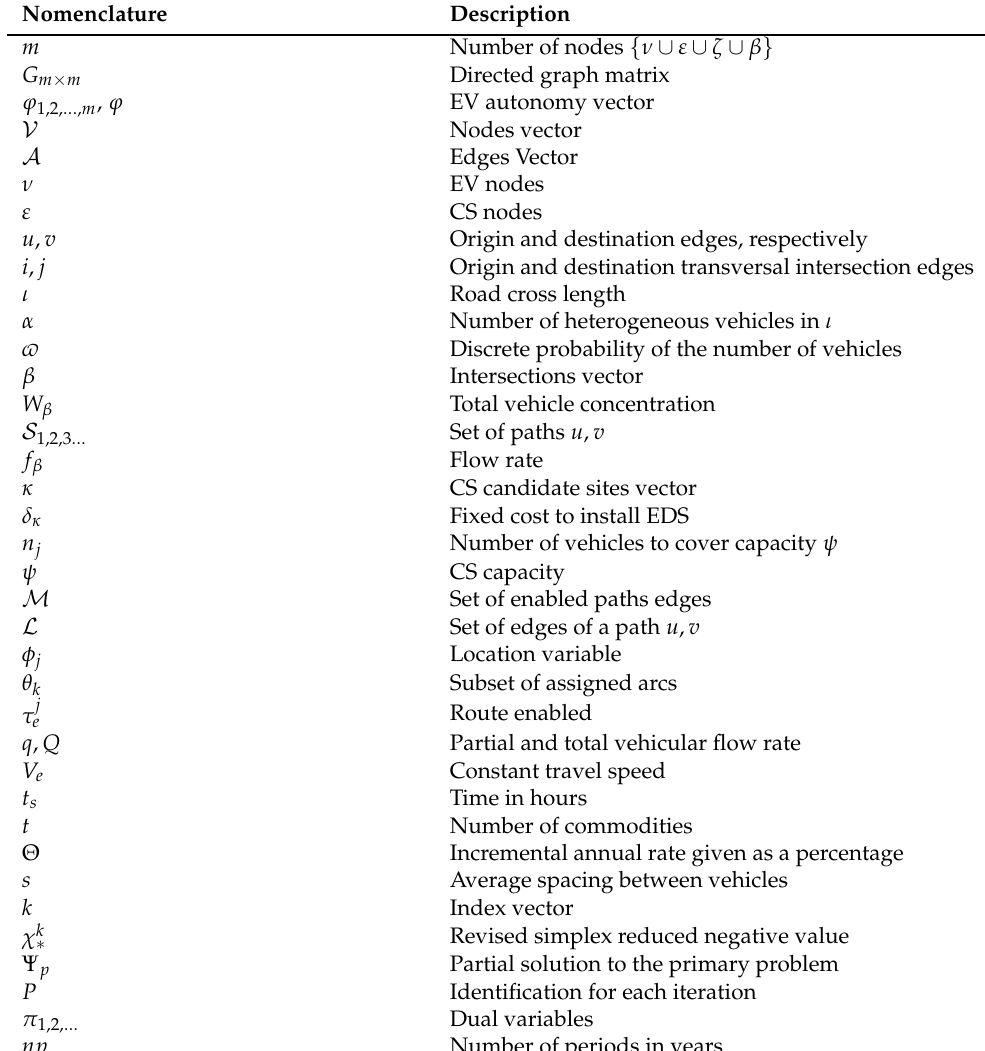
Table 4. Notation used in this